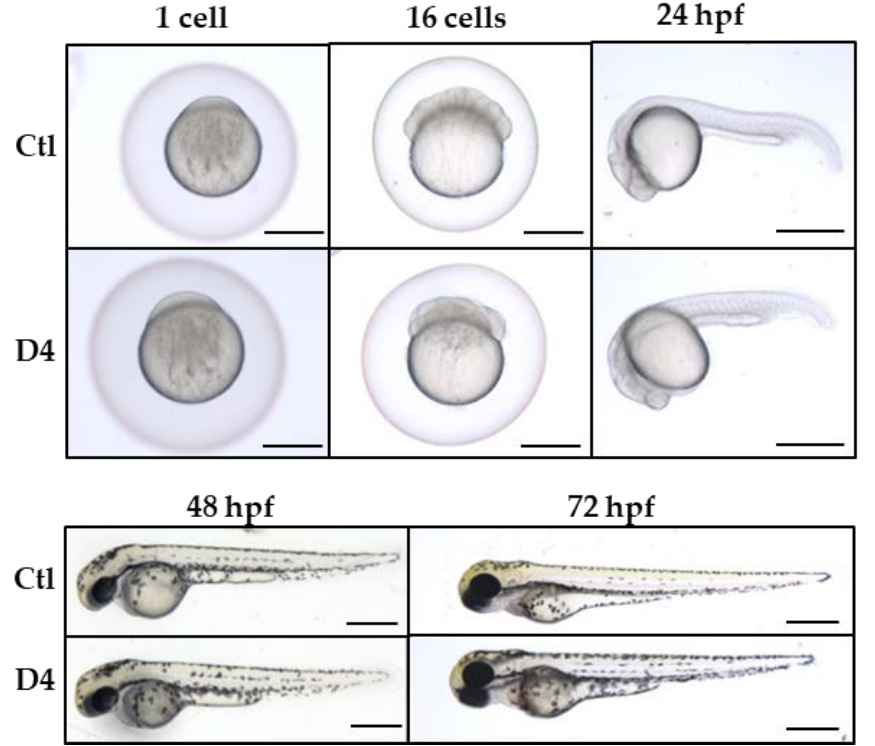
Figure 2. Morphological characterization of D4 mutant embryos. Comparison of the morphological features of control and mutant embryos from 1 hpf till 3 dpf. Three biological replicates, N > 100 for Ctl and D4. Size bar = 500 µm.